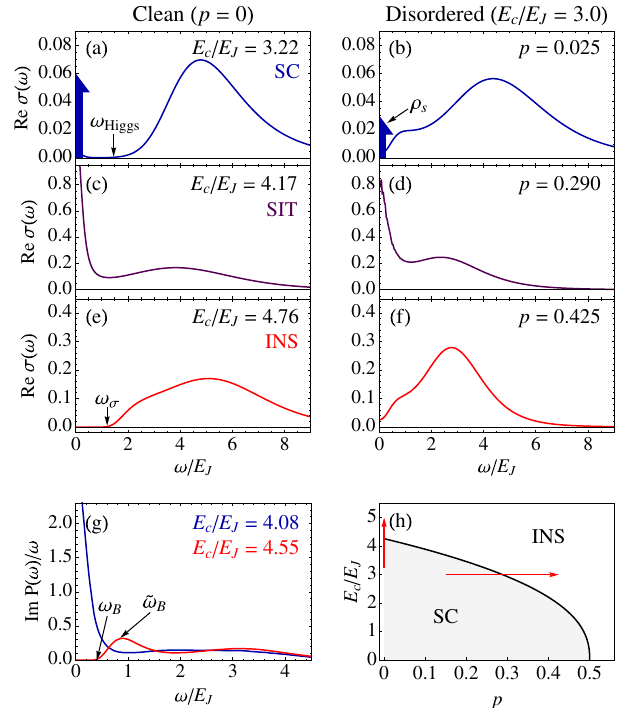
FIG. 3. (a) – (f) Re σ ð ω Þ across the (a),(c),(e) clean ( p ¼ 0 ) and (b),(d),(f) disorder-tuned (fixed E c =E J ) superconductor-insulator transitions. (g) Boson spectral function Im P ð ω Þ = ω for clean superconducting (blue line) and insulating (red line) states. The energy scales shown in Fig. 2 are indicated in (a) – (g). All quantities are at fixed temperature T=E J ¼ 0 . 156 and fixed system size 256 × 256 for the clean case and 64 × 64 for the disordered. In the disordered system, the spectral functions are marked by a significant increase in low-frequency weight, obscuring the gap scales of the clean system. (h) Schematic phase diagram showing how the SIT can be crossed by either increasing E c =E J or by tuning the disorder p